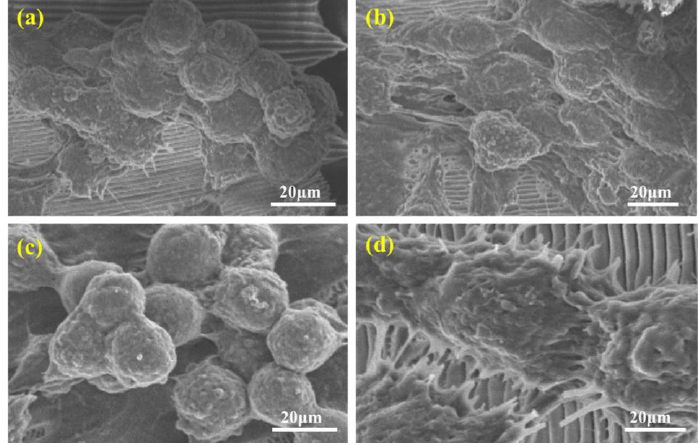
( a ) M. menelaus , ( b ) P. u. telegonus (blue area), ( c ) P. u. telegonus (fibrous area), and ( d ) O. c. lydius wings.